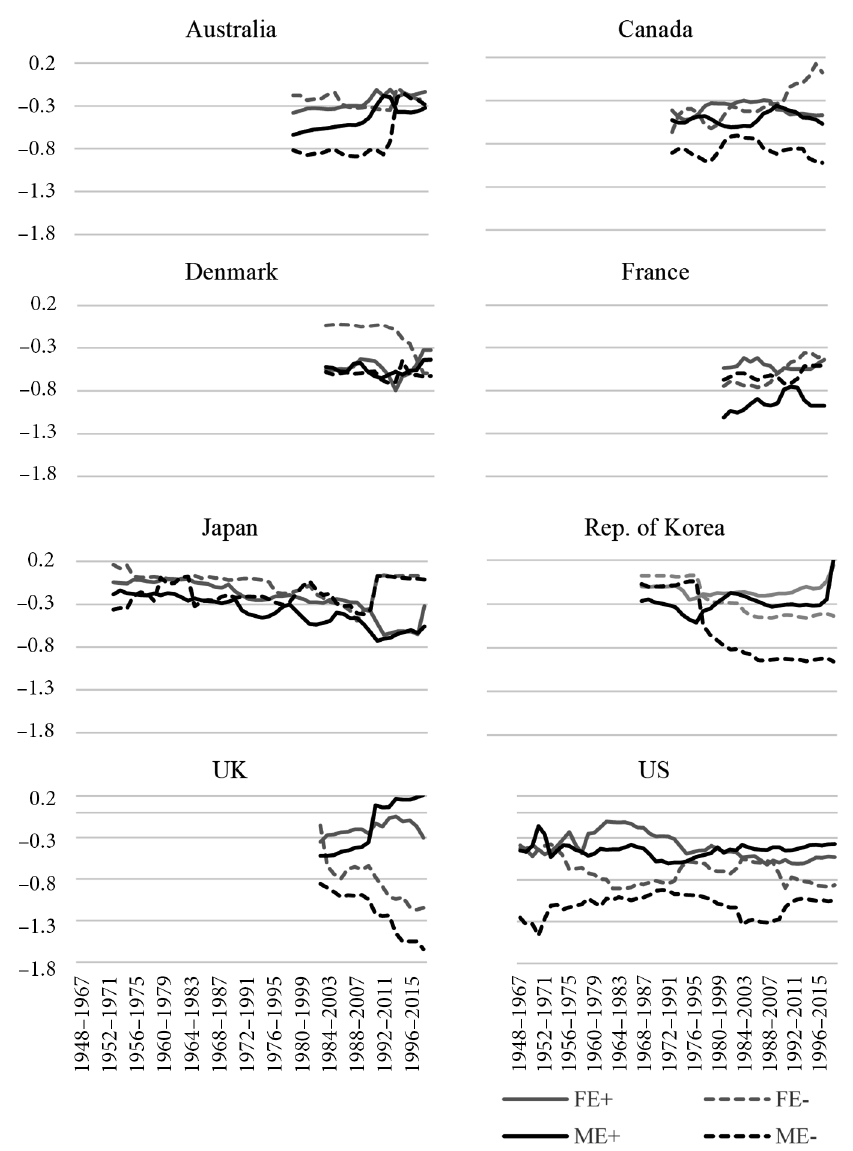
Figure 2. Coefficients of moving regression for 20-year periods – models for deviations from the trend (change in a number of working persons towards changes in a number of the unemployed for increases and decreases in a number of working persons) in selected countries (source: own calculations based on the ILO